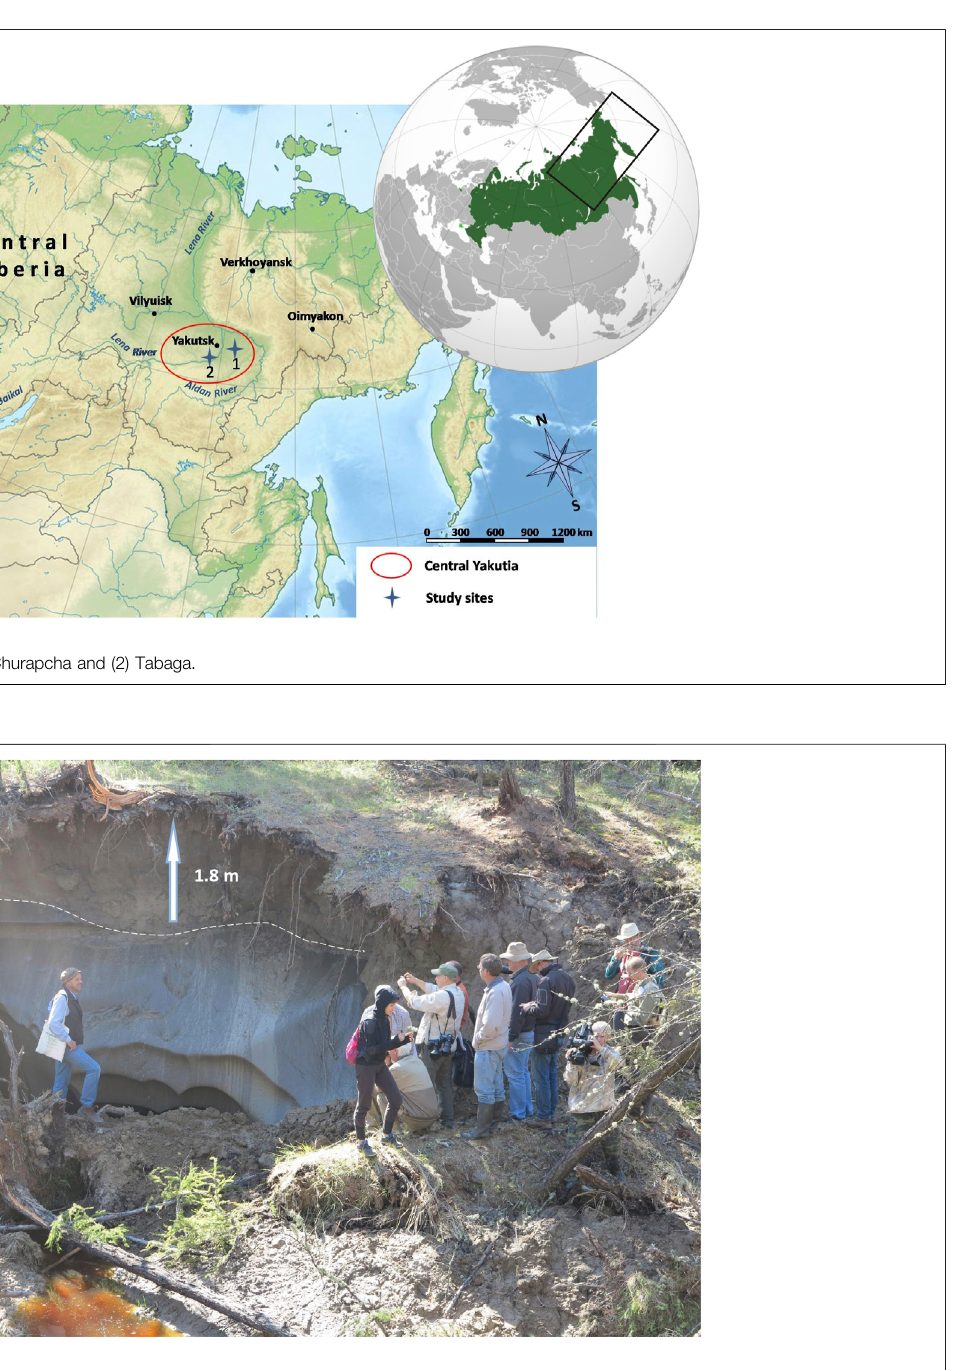
FIGURE 2 | The upper boundary of an ice wedge lies at a depth of about 2